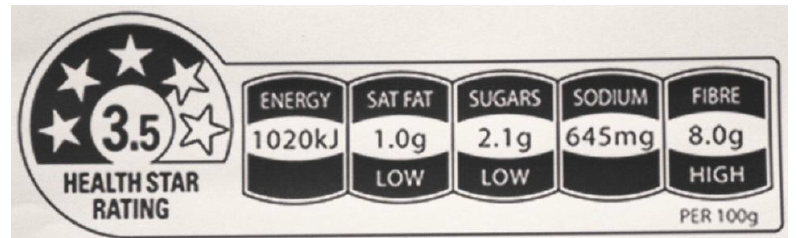
Figure 1. The voluntary, front-of-pack “Health Star Rating” label (Australia) [43] (Health Star Rating trademarks are owned by the Commonwealth of Australia.